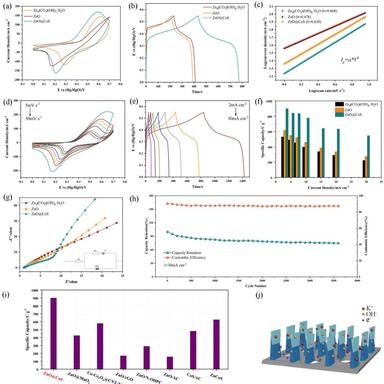
(a) Comparative cyclic voltammetry curves of ZnO@CoS, ZnO and ZnO precursor electrodes (30 mV s−1); (b) Galvanostatic charge-discharge curves of the ZnO@CoS, ZnO and ZnO precursor electrodes (5 mA cm−2); (c) Power law dependences of redox peak current on scan rate for ZnO@CoS, ZnO and ZnO precursor electrodes; (d) Cyclic voltammetry curves of the ZnO@CoS electrode at various scan rates; (e) Galvanostatic charge-discharge curves of the ZnO@CoS electrode at various current densities; (f) Comparative specific